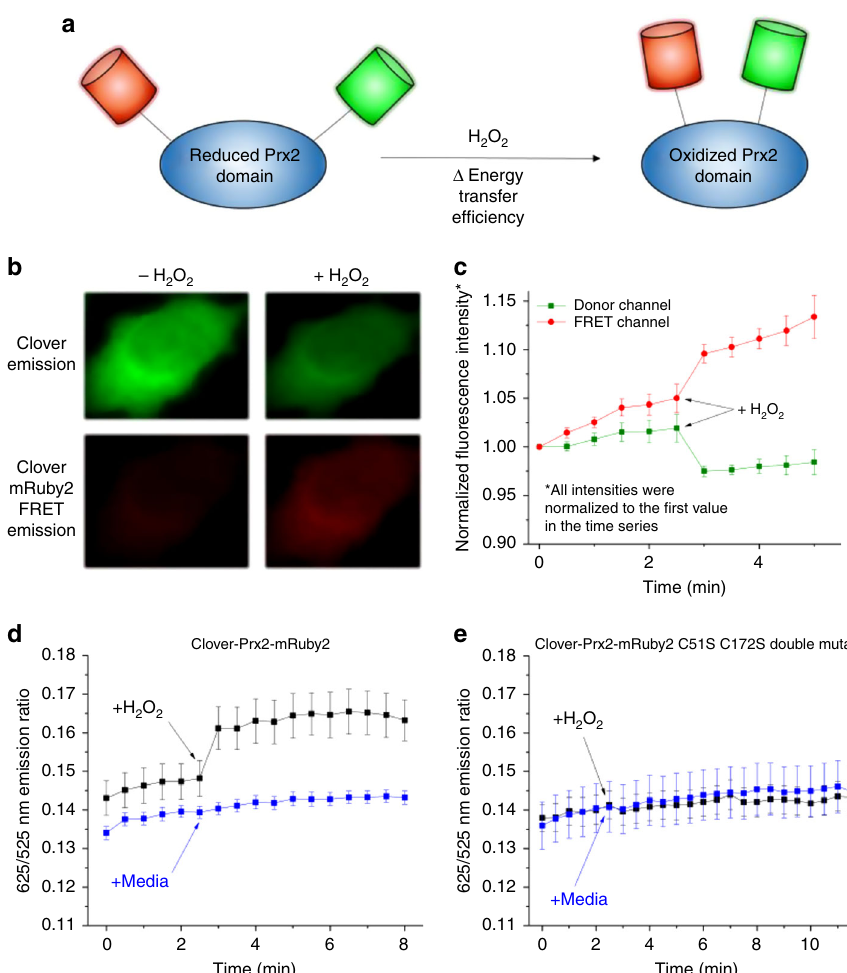
Fig. 1 Design and function of human Prx2-based FRET probe. a Schematic representation of Prx2 based probe. b Response of cytosolic sensor upon oxidation by H 2 O 2 . Changes in each of the two fl uorescent channels upon stimulation with H 2 O 2 suggest that the fusion protein adopts a conformation in which the two fl uorophores are in closer proximity in the oxidized state. Pseudo-coloring of one HeLa cell is shown for illustrative purposes. c Normalized emission from the donor and FRET fl uorescent channels over time upon stimulation with approximately 60 × 10 − 15 mol per cell in HeLa cells expressing the functional Prx2 probe. d 625/525nm emission ratio over time in HeLa cells expressing the functional Prx2 probe upon stimulation with a control bolus (culture medium only, blue line) or stimulation with approximately 60 × 10 − 15 mol H 2 O 2 per cell (black line). e 625/525nm emission ratio over time in HeLa cells expressing Prx2-based probe with both the Prx2 catalytic cysteine residue and resolving cysteine residue mutated to serine upon stimulation with a control bolus (culture medium only, blue line) or stimulation with approximately 60 × 10 − 15 mol H 2 O 2 per cell (black line). 2 mL of 20 μ M H 2 O 2 was added to 7 × 10 5 adherent cells to achieve 60 × 10 − 15 mol H 2 O 2 per cell. Data points represent mean emission ratio ± S.E.M. for nine cells and are re fl ective of three biological H 2 O 2 per cell as opposed to concentration or total moles of H 2 O 2 . As we and others have previously shown 31 – 34 , both the total moles of H 2 O 2 added as well as the total number of cells present affect the results obtained from this kind of experiment, whereas moles of H 2 O 2 per cell is a meaningful metric that may be compared across studies.